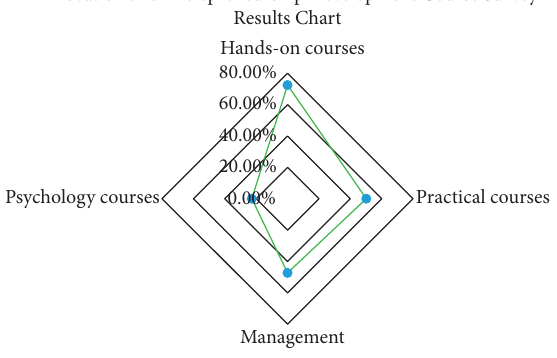
Figure 11: Survey results of IEE